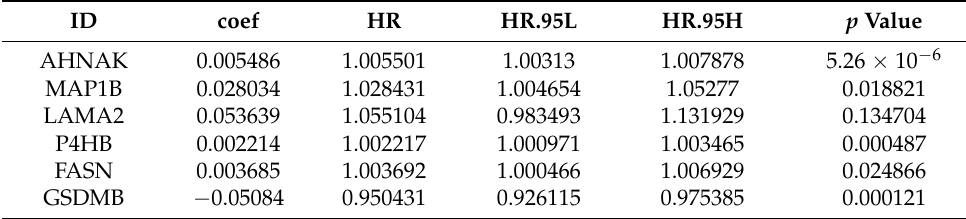
Table 3. Six RNA-binding proteins and their hazard